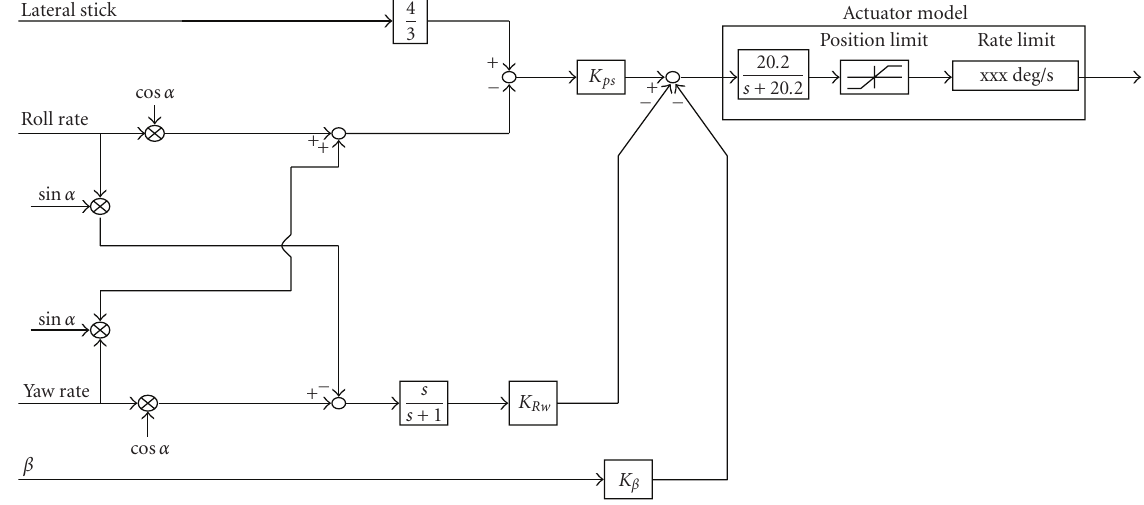
Figure 1: Block diagram of lateral flight control system.